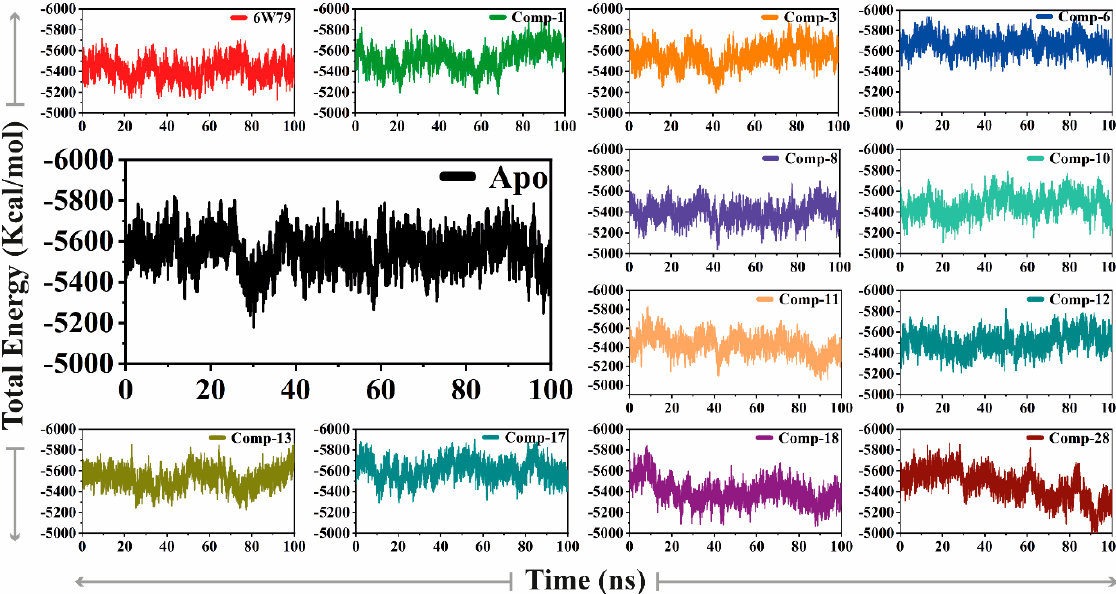
Figure 3. RMSF graphs of apo–M pro , M pro – X77 , and M pro in complex with selected hits. The RMSF of free state was in range of 0.5 Å to 1.3 Å. Compound 8 attained highest RMSF (between 1.5 Å and 3.5 Å), while the complex with X77 showed RMSF between 1.0 Å and 1.8 Å.